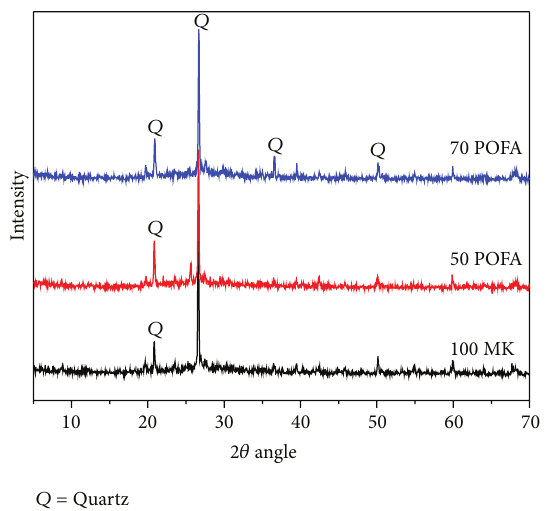
Figure 5: X-ray diffraction of 28-day ambient cured geopolymer.